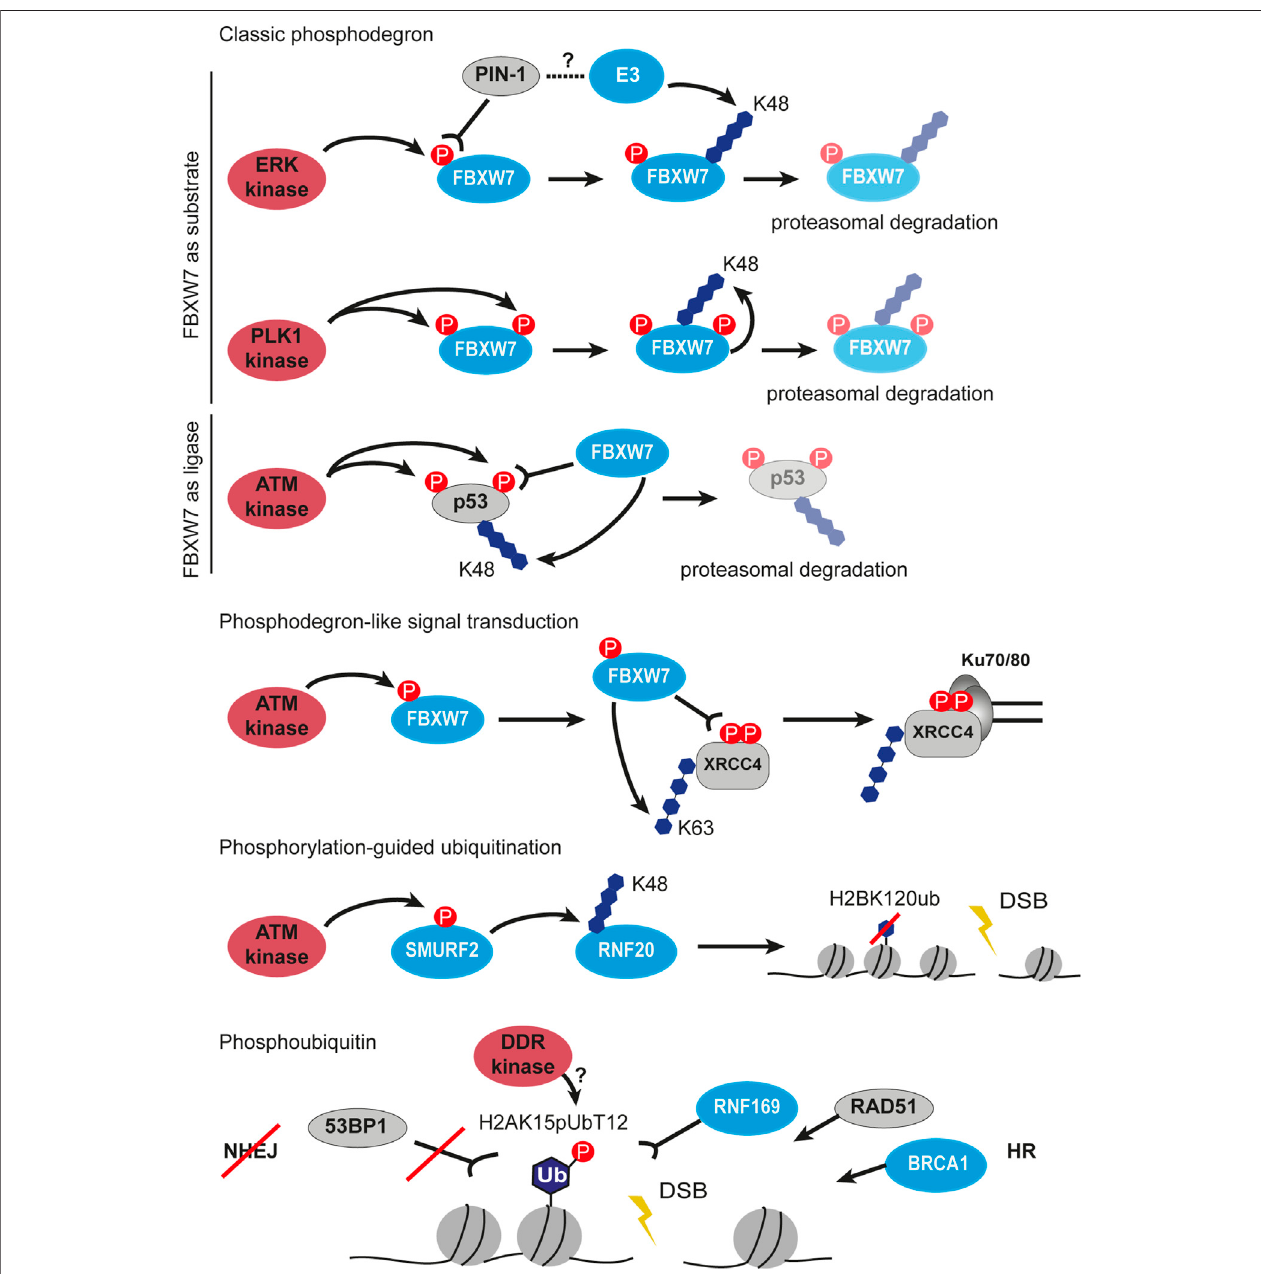
FIGURE 4 | Crosstalk between phosphorylation and ubiquitination in DSB signaling and repair. First three panels describe the classic phosphodegron situations highlightingFBXW7assubstratetophosphorylationandasphosphorylationreadingubiquitinligase.Next,phosphodegron-likesignaltransductionbyFBXW7isshown, which results in ubiquitination and stabilization of XRCC4 at Ku70/80 covered DSB. The next panel depicts phosphorylation-guided ubiquitination involving sequential signaltransferbytwoubiquitinligasesSMURF2andRNF20.Thelastexampleofthecrosstalkbetweenphosphorylationandubiquitinationisthephosphorylationof the ubiquitin moiety. The H2AK15pUbT12 is recognized by the HR factors such as RNF169, RAD51 and BRCA1, but prevents binding of 53BP1 at DSB. P, phosphorylation, Ub, ubiquitin.